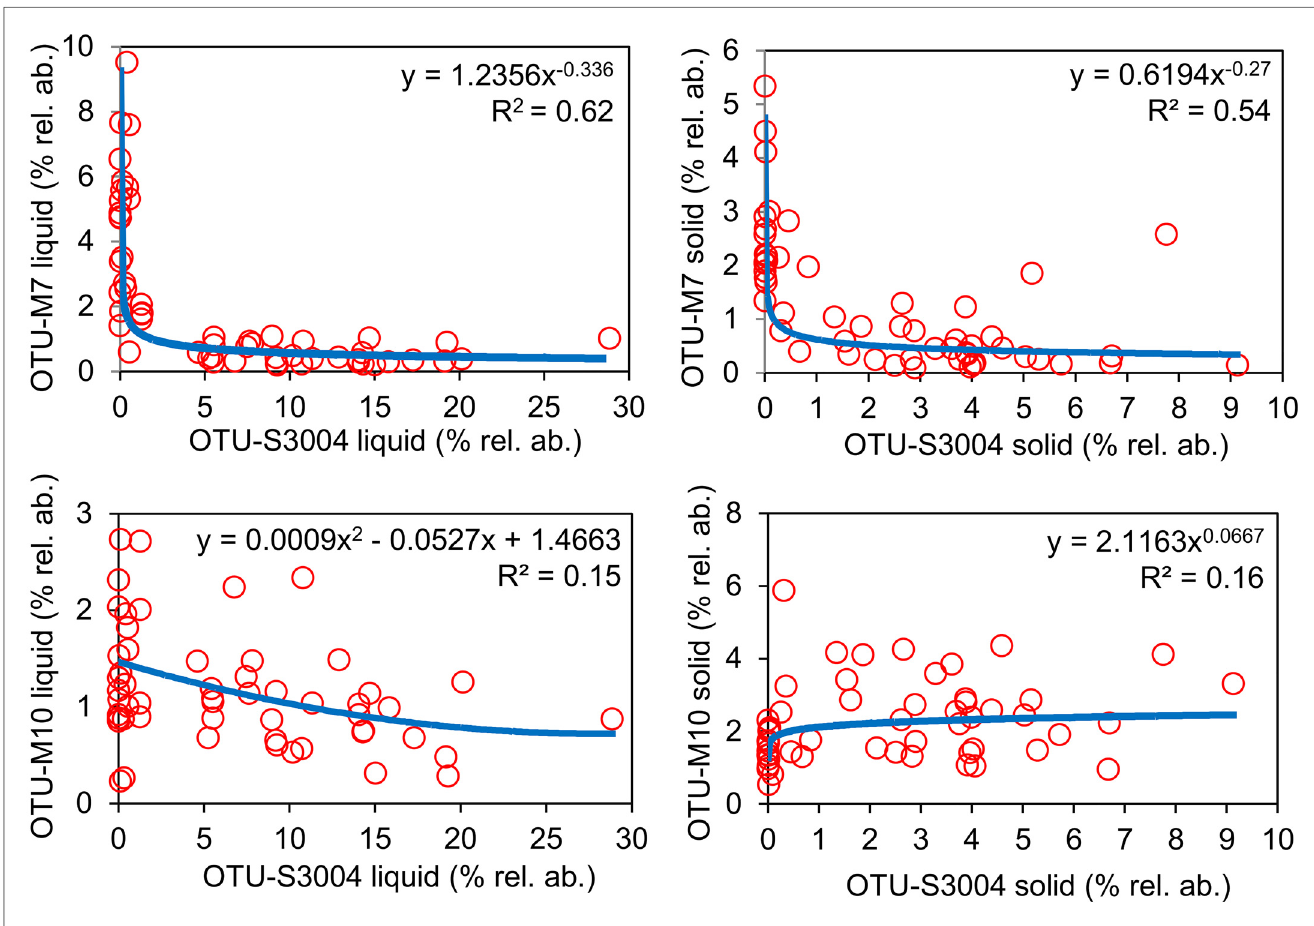
Fig 9. Correlation analysis of OTU-M7 and OTU-M10 with OTU-S3004. Scatter plot analysis of percentage relative abundances (% rel. ab.), in all liquid and solid fraction samples, of OTU-M7 ( Methanobrevibacter gottschalkii clade) and OTU-M10 ( Methanobrevibacter ruminantium clade) plotted against OTU-S3004. Power regression (blue dashed line) showed the highest R 2 values (shown on each scatter plot) in all comparisons apart from OTU-M10 (liquid) vs. OTU-S3004 (liquid) for which a polynomial regression showed the highest R 2